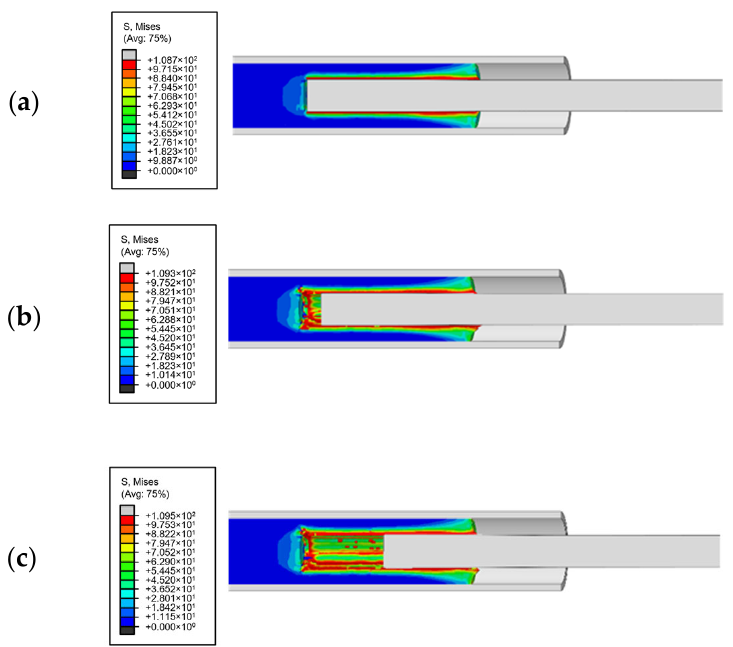
Figure 11. Pullout failure process of reinforcement. ( a ) Stripping of reinforcement and grouting material interface. ( b )Reinforcement pullout. ( c ) Reinforcement completely pullout